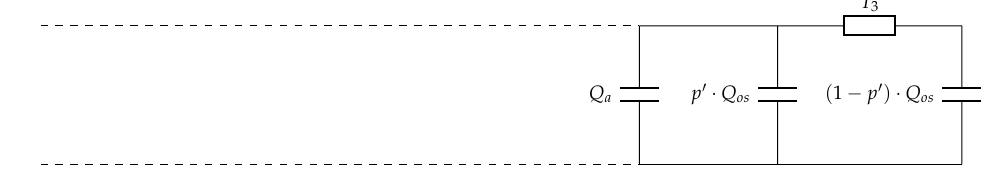
Figure 12. Transient representation of thermal parameters for outer covering.